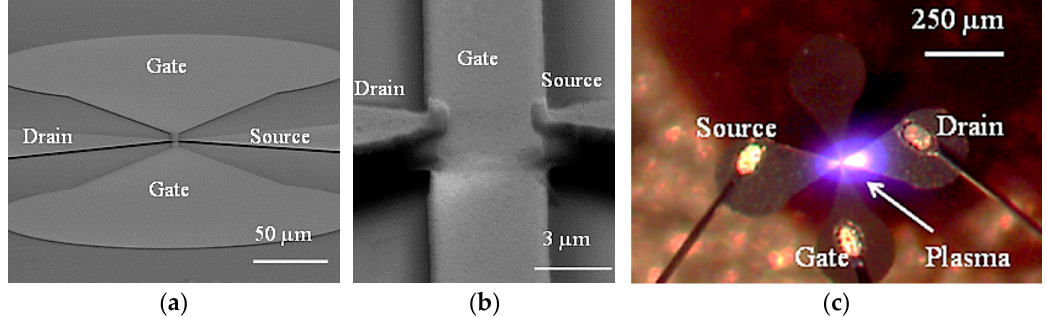
Figure 10. ( a , b ) SEM micrographs of the device. The small overlap are between gate and source/drain electrodes reduce the gate capacitance and help achieve higher switching speeds. ( c ) Optical image of the packaged device during operation with rf excitation. The devices were wire-bonded, packaged and sealed with a Plexiglas plate. Helium was continuously supplied to the package through a tubing [25].